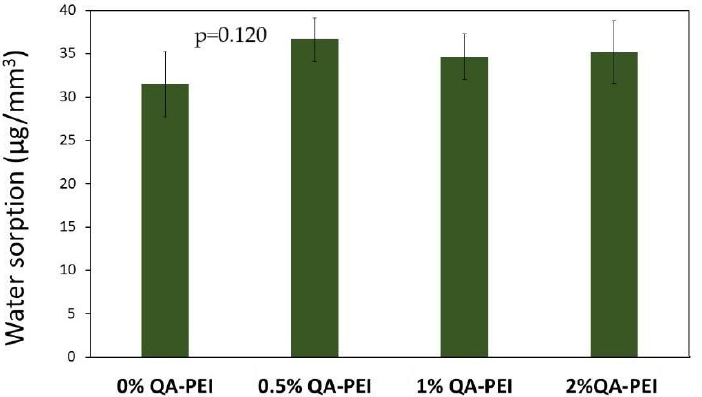
Figure 10. WS values of the materials. All the results for WS were statistically insignificant ( p > 0.05).